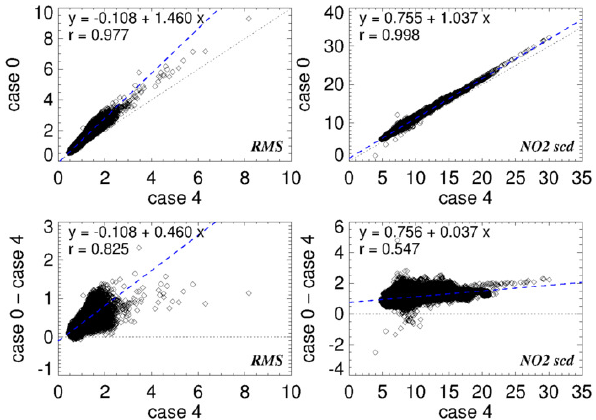
Figure 12. Scatter plots of current data (case 0, top row) and ab- Fig.12. Scatterplotsofcurrentdata(case0,toprow)andabsolutedifferencesbetweenthecurrentandtheup- dateddata(bottomrow)oftheRMSerror(leftcolumn, × 10 − 4 )andNO 2 SCD(rightcolumn, × 10 15 molec/cm 2 ) solute differences between the current and the updated data (bot- asfunctionoftheupdateddata(case4)usingtheJuly2005averagegriddeddata. Dashedbluelinesshowlinear tom row) of the RMS error (left column, × 10 − 4 ) and NO 2 SCD fitsthroughthedata;thefitandcorrelationcoefficientsareshowninthetop-leftofeachgraph. (right column, × 10 15 moleccm − 2 ) as a function of the updated data (case 4) using the July 2005 average gridded data. Dashed blue lines show linear fits through the data; the fit and correlation coeffi- cients are shown in the top-left of each graph. Figure 13. Monthly average gridded updated (case 4; top panel) Fig. 13. Monthly average gridded updated (case 4; top panel) NO 2 slant column data for July 2005 and the correspondingdifferencewiththecurrent(case0)data(lowerpanel). NO 2 slant column data for July 2005 and the corresponding differ- ence with the current (case 0) data (lower 34